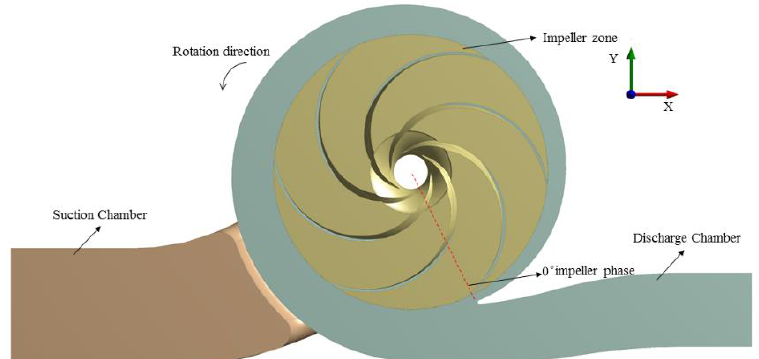
Figure 4. Middle section plane view of the hydraulic model.